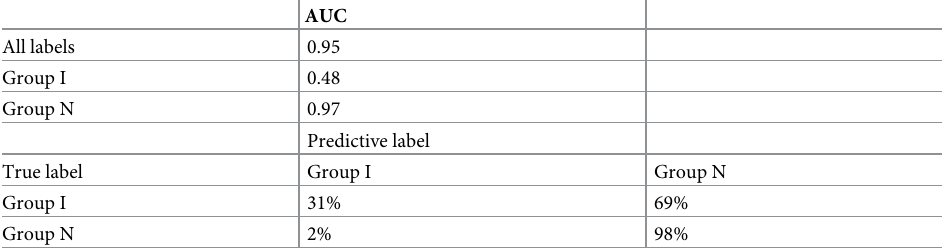
Table 1. Groups I and N model of the colon; AUC and confusion matrix. The confusion matrix shows how often each label was correctly classified in the model (Predictive and True labels’ agreement) and the labels that were con- fused for that label (Predictive and True labels’ disagreement).